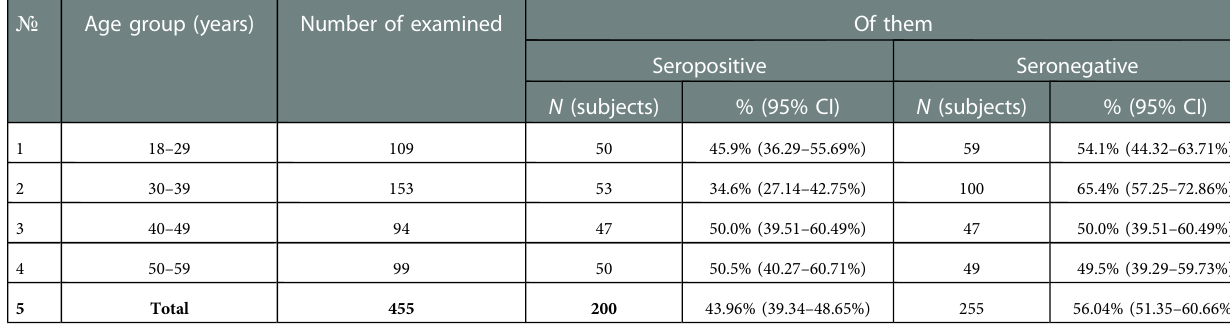
TABLE 6 IgG blood serum levels to pertussis in healthcare